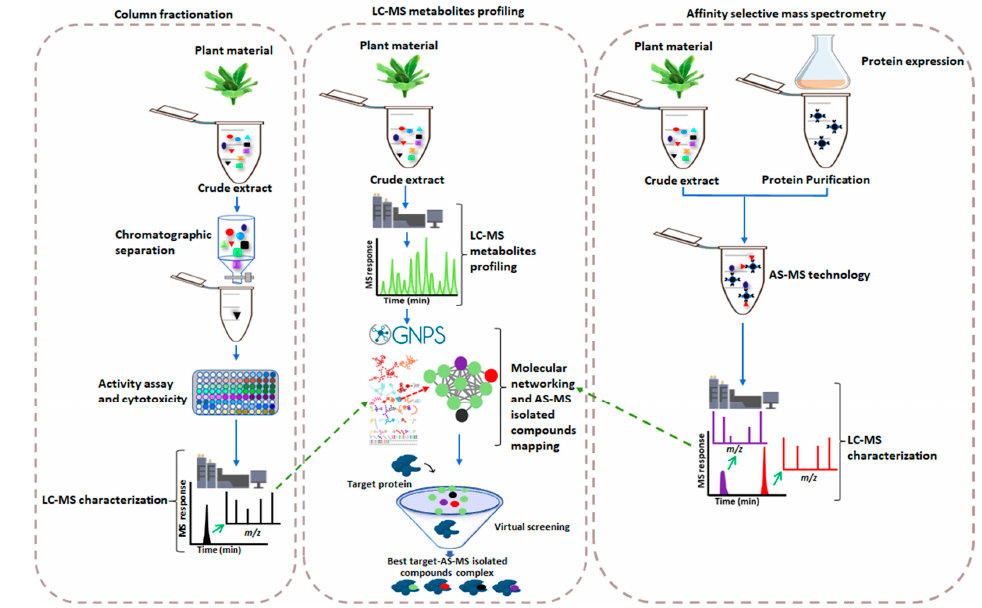
Figure 1. Comparative illustration of conventional drug discovery (on the left) vs. AS-MS-based drug discovery (on the right) and how AS-MS is explored further to increase the possibilities of finding bioactive compounds using molecular networking (in the middle). In the molecular net- work, compounds that were initially identified using AS-MS (colored red and purple) will appear as nodes with other surrounding nodes (colored green) representing compounds with similar struc- tures; these compounds can be virtually screened for binding affinity to target proteins, increasing the chances of finding more drug lead compounds. Green arrows indicate mapping of the LC-MS characterized ligands into molecular networking.